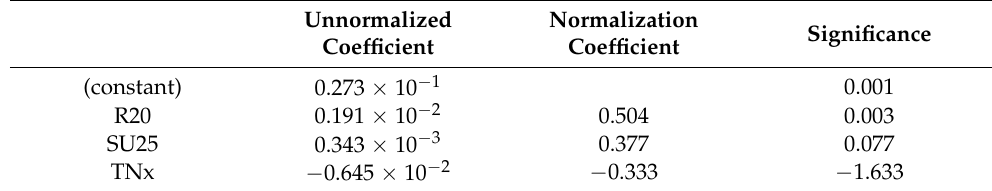
Table 3. Results of multiple linear regression between the extreme climate index and the normalized difference vegetation index (NDVI) for the Mongolian Plateau.